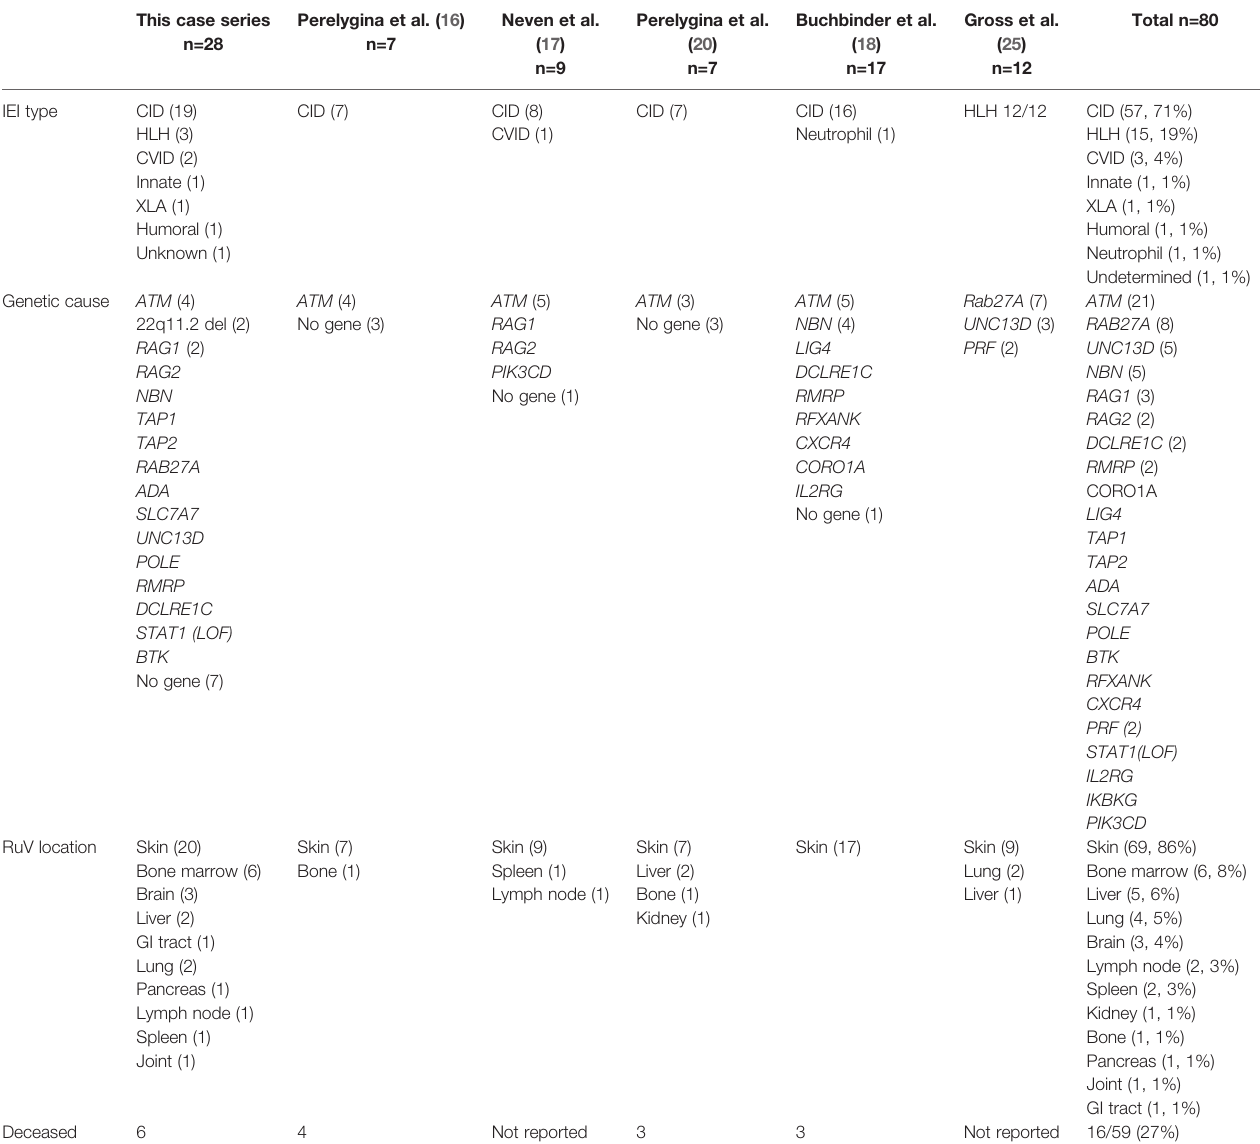
TABLE 3 | RuV-associated in fl ammation in IEI patients described in this case series and reported in the